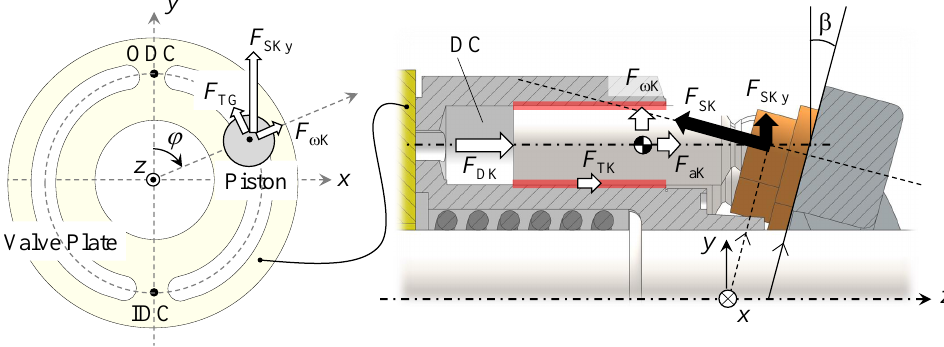
Figure 2. Forces on piston (see in [1] for details).